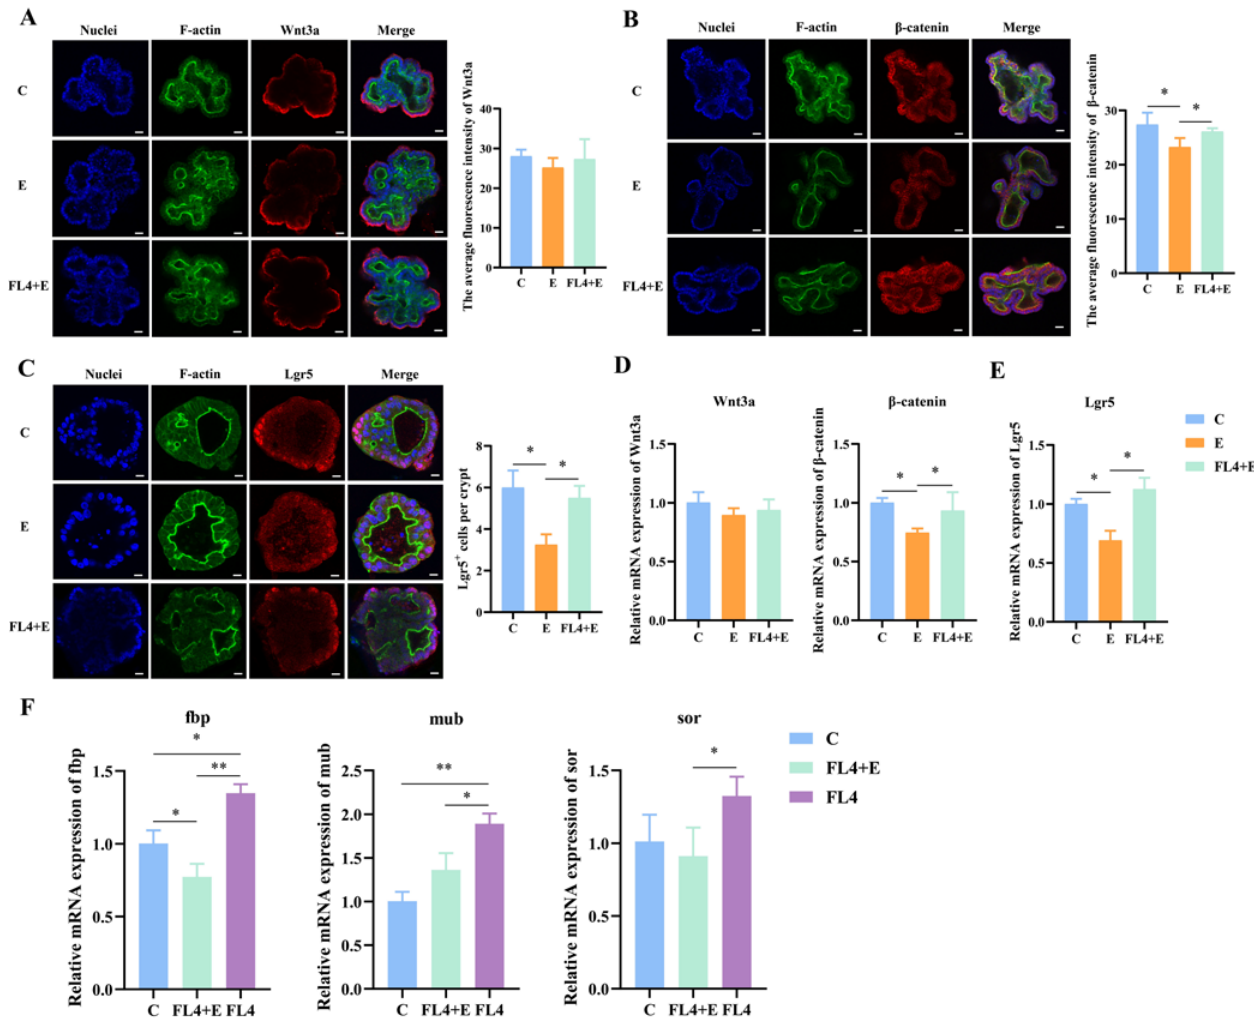
Figure 6. L. fermentum FL4 affected the Wnt/β -catenin pathway to alleviate the damage induced by ETEC K88. ( A , B ) Basal-out organoids were stained with Wnt3a and β -catenin (red). Nuclei were stained with 4 ′ ,6-diamidino-2-phenylindole (DAPI, blue), cytoskeletons were stained with F-actin (green). Scale bars, 20 µm. ( C ) Basal-out organoids were stained with Lgr5 (red). Nuclei were stained with 4 ′ ,6-diamidino-2-phenylindole (DAPI, blue), cytoskeletons were stained with F-actin (green). Scale bars, 20 µm. ( D , E ) RT-qPCR analysis of the Wnt3a, β -catenin and Lgr5 in organoids, n = 3. ( F ) Relative expression of adhesion marker genes fbp, mub, sor, n = 3. * p < 0.05, ** p < 0.01.